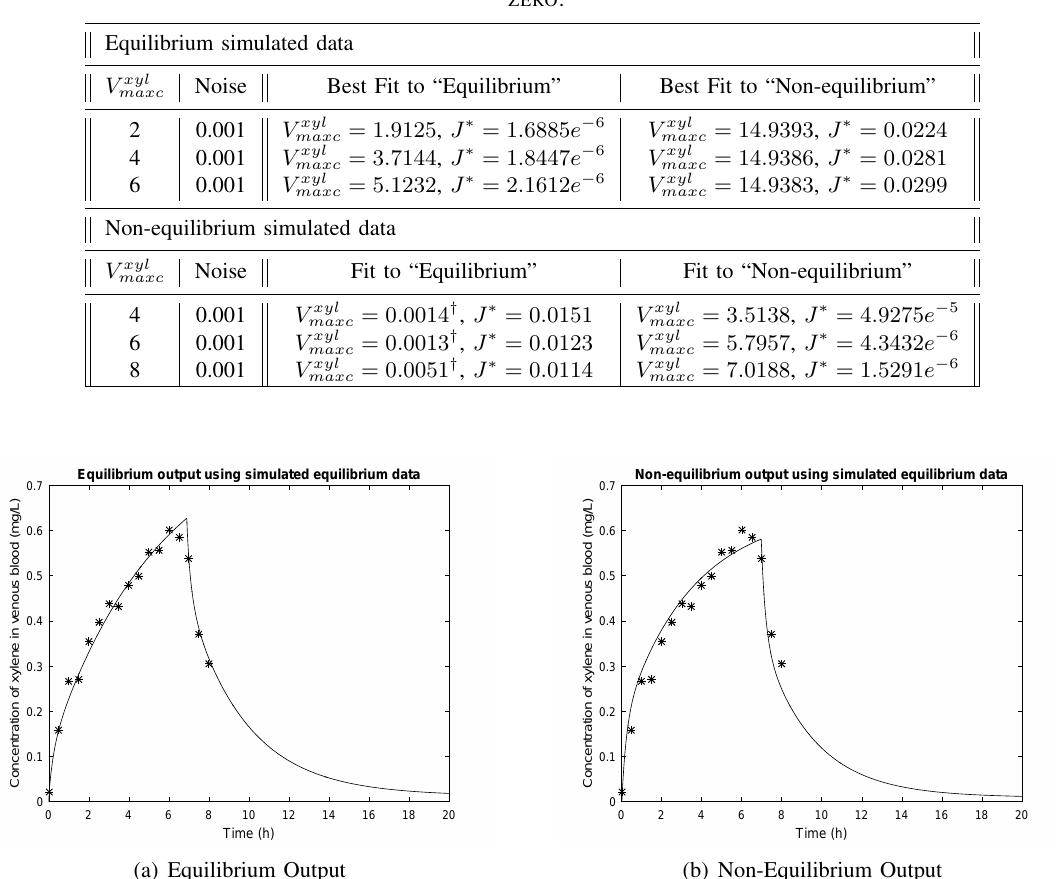
O PTIMAL COST USING SIMULATED DATA FOR THE CONCENTRATION OF XYLENE IN EXHALED AIR . T HE V xyl maxc VALUE USED FOR SIMULATION IS LISTED IN COLUMN 1 OF THE TABLE , AND INITIAL GUESSES FOR V xyl maxc FOR THE OPTIMIZATION ROUTINE WERE 3, 6, AND 10. T HE VALUE FOR J ∗ THAT WAS LOWEST FOR THE THREE IS LISTED BELOW . I N CASES MARKED WITH ( † ) THE SAME COST WAS FOUND FOR VARIOUS V xyl maxc VALUES , ALL OF WHICH WERE CLOSE TO ZERO .